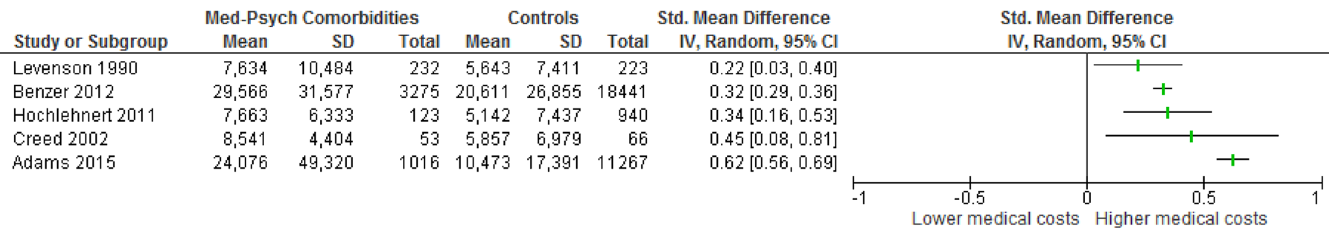
Fig 3. Relationship between medical-psychiatric comorbidity and medical costs.